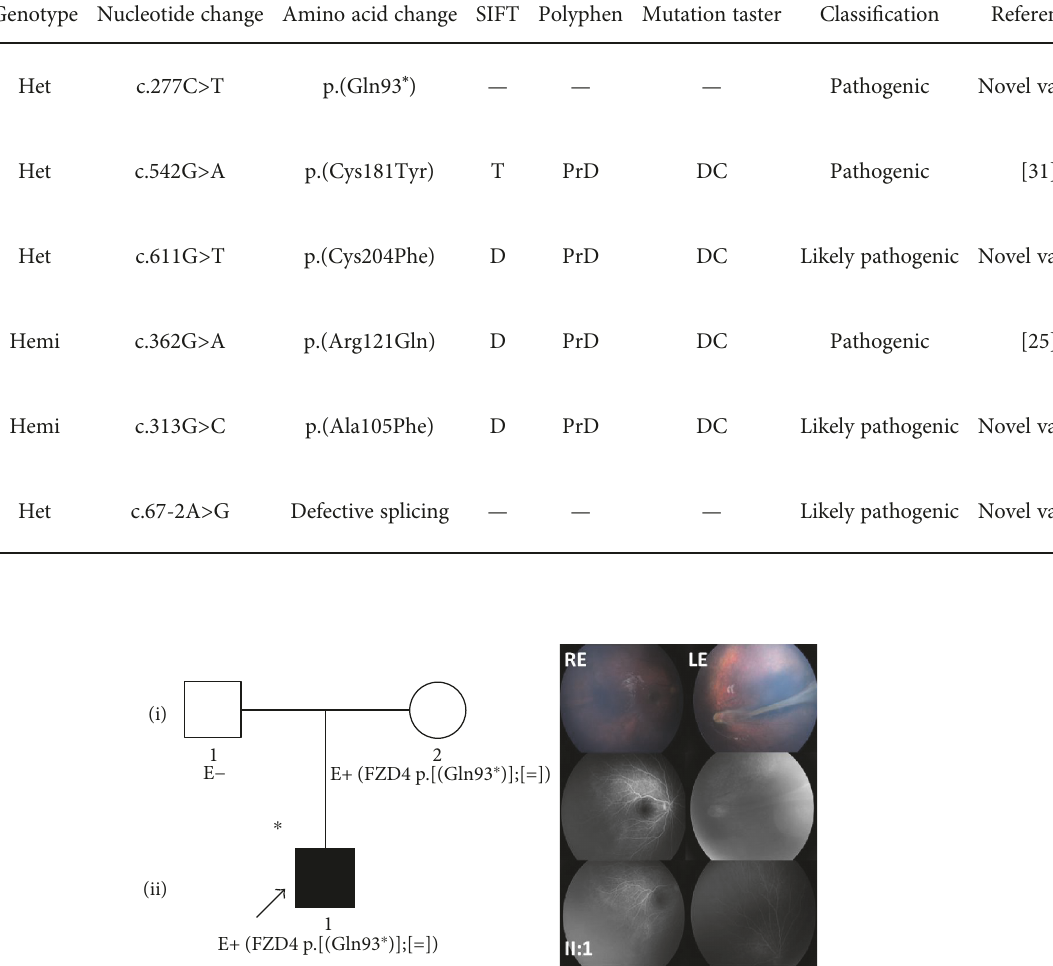
Figure 1: Pedigree and ocular features of family 1. Color fundus photographs by RetCam and fl uorescein angiograms from the 9 y/o male proband (II:1) of family 1. The RE presented normal posterior pole; however, the fl uorescein angiography showed a large area of avascular retina in the peripheral retina (FEVR stage 1). No signs of neovascularization or peripheral exudation were noticed. The LE presented a falciform retinal fold anchored to the temporal retinal sector without signs of peripheral exudation (FEVR stage 3A). ∗ Documented clinical evaluation; E+ and E − , positive and negative to genetic test, respectively; RE, right eye; LE, left